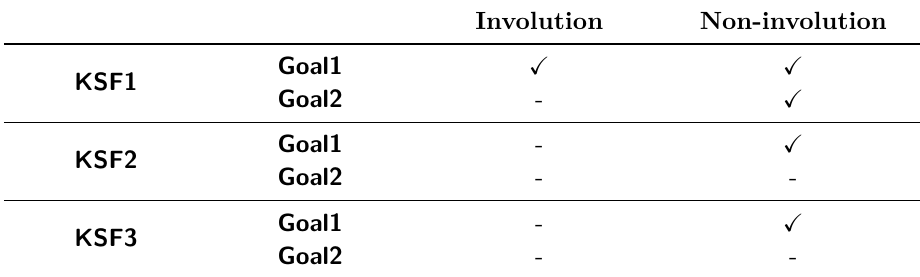
Table 6: Existence of S-boxes that prevents invariant subspace attacks Involution